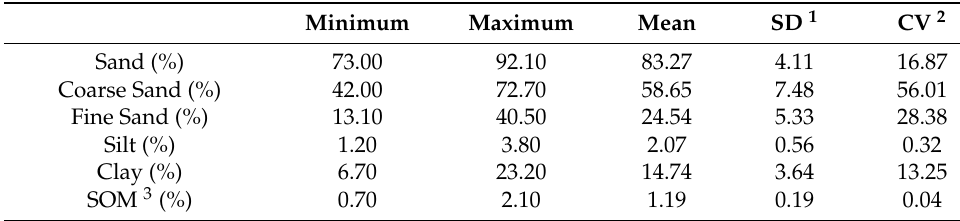
Table 4. Soil attributes values obtained by laboratory analyses. Minimum